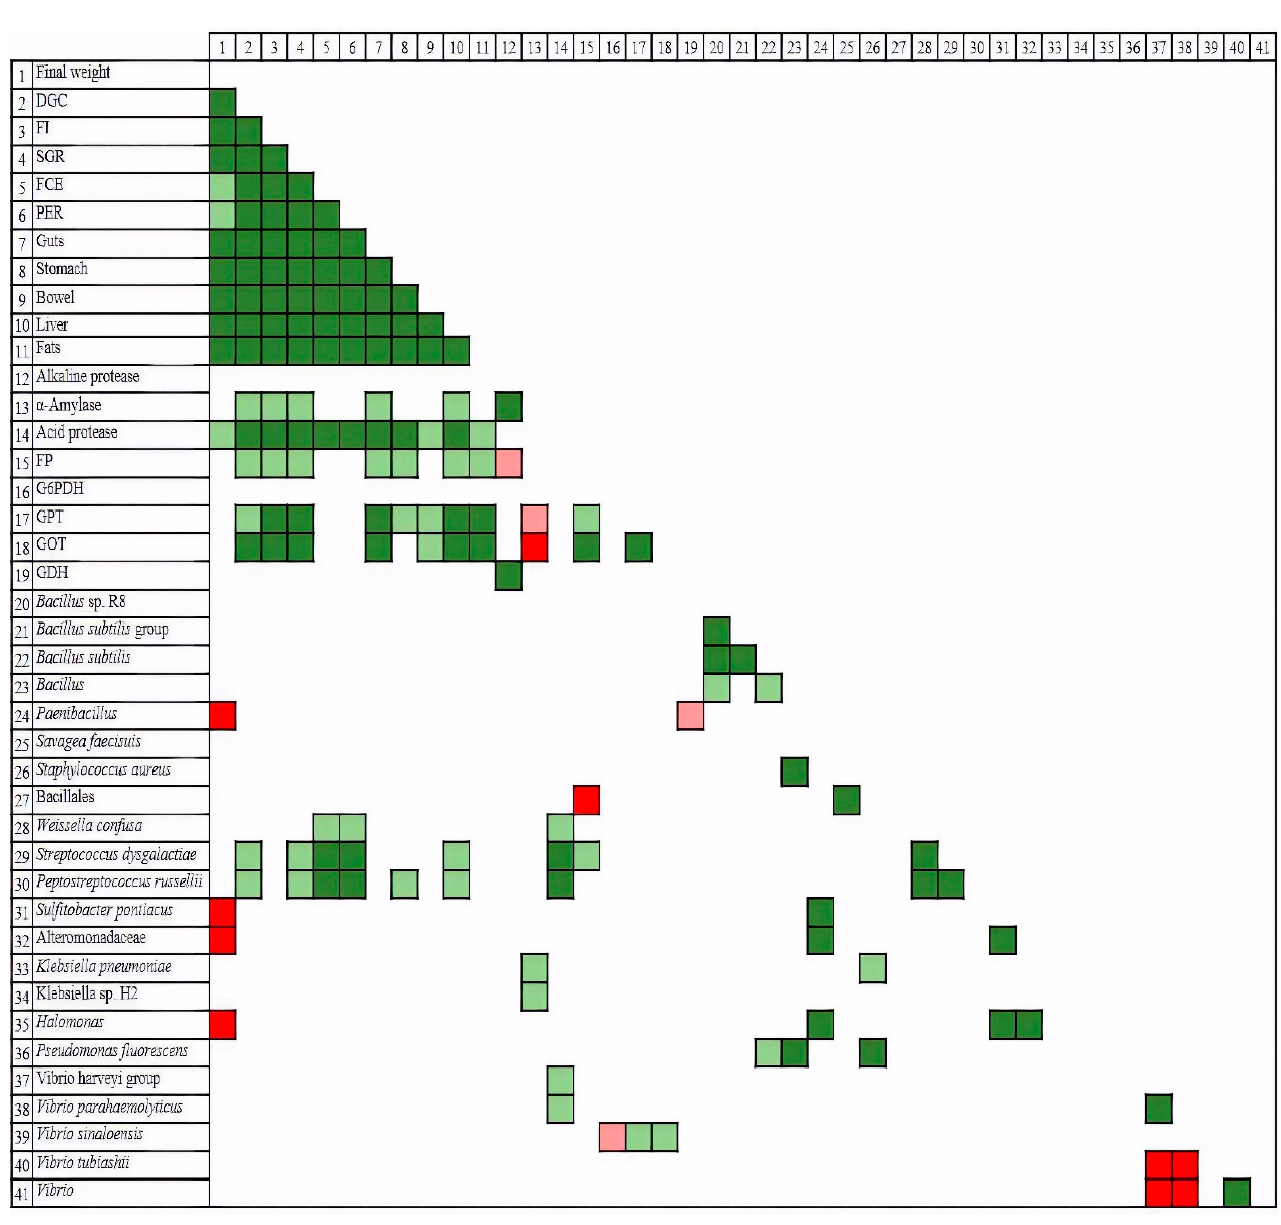
Figure 5. Correlations between parameters according to Pearson correlation analysis: positive results are depicted in green and negative results in red. Dark and light colors reveal significance at 99% and 95% confidence levels, respectively.